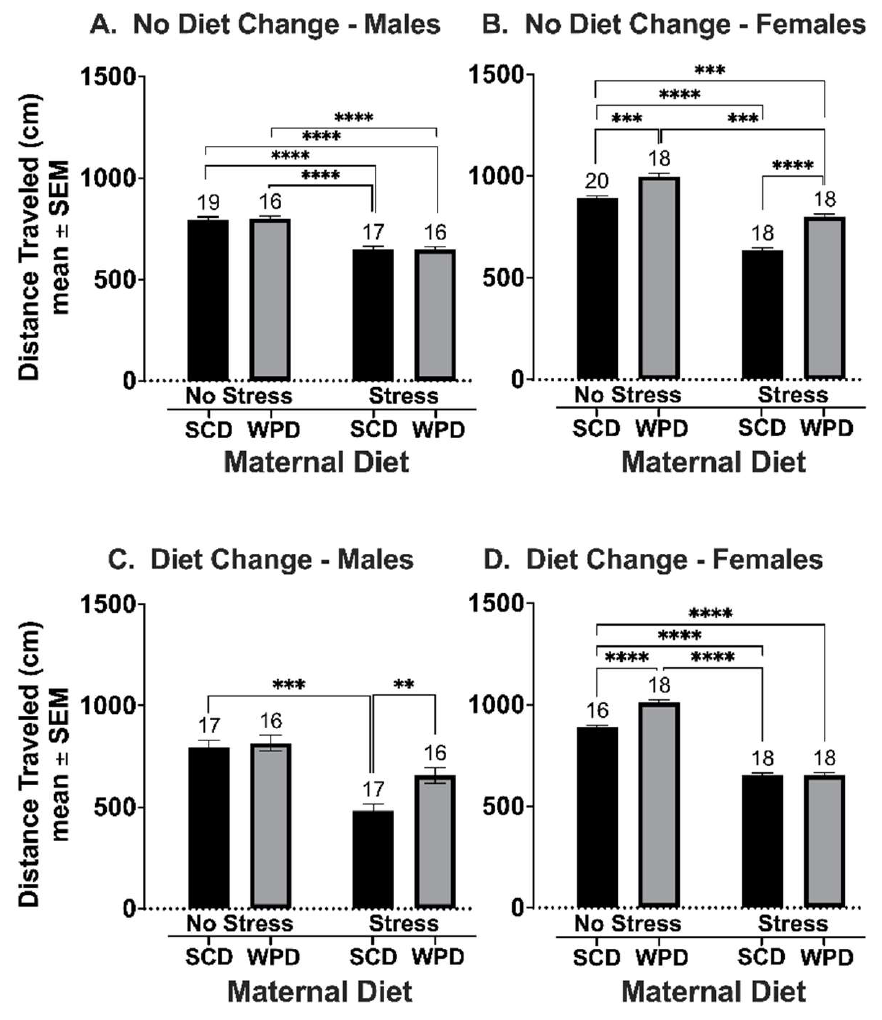
Figure 5. Total distance traveled in the OF for ( A ) males whose diets remained consistent at weaning; ( B ) females whose diets remained consistent at weaning; ( C ) males whose diets were switched at weaning; and ( D ) females whose diets were switched at weaning. Group n ’s located above bars. WPD = western pattern diet; SCD = standard chow diet. ** p < 0.01; *** p < 0.001; **** p < 0.0001. For animals whose diets were switched at weaning, there was a significant three-way interaction between PS, maternal diet, and sex on the amount of time spent in the inner zone of the OF (F (1, 129) = 24.68, p < 0.001). Overall, the offspring of PS dams spent less time in the inner zone of the OF compared to the offspring of NS dams ( t (37.3) = 19.9, p < 0.001) (see Figure 6C,D). Male NS+SCD + spent significantly more time in the inner zone of the OF than their NS+WPD + counterparts ( t (33.4) = 6.19, p < 0.001). Although the male offspring of PS dams spent less time in the inner zone of the OF overall, male PS+WPD + spent significantly more time in the inner zone than their PS+SCD + counterparts ( t (21) = − 3.67, p = 0.009). Alternatively, there was no effect of diet on the female offspring of PS dams. However, female NS+SCD + spent significantly more time in the inner zone of the OF than their NS+WPD + counterparts ( t (27.2) = 4.92, p <